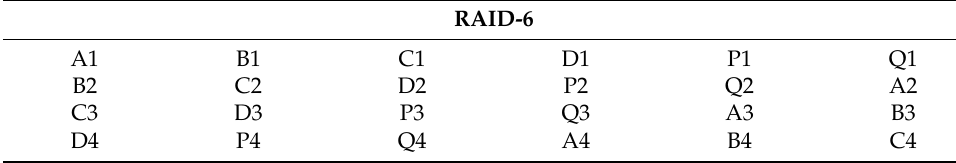
Table 3. RAID-6 configuration structure.